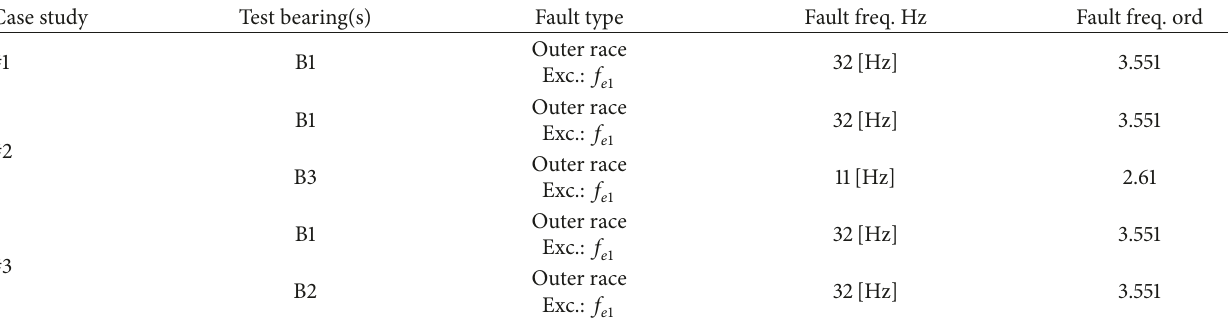
Table 2: Details of the numerical case studies.